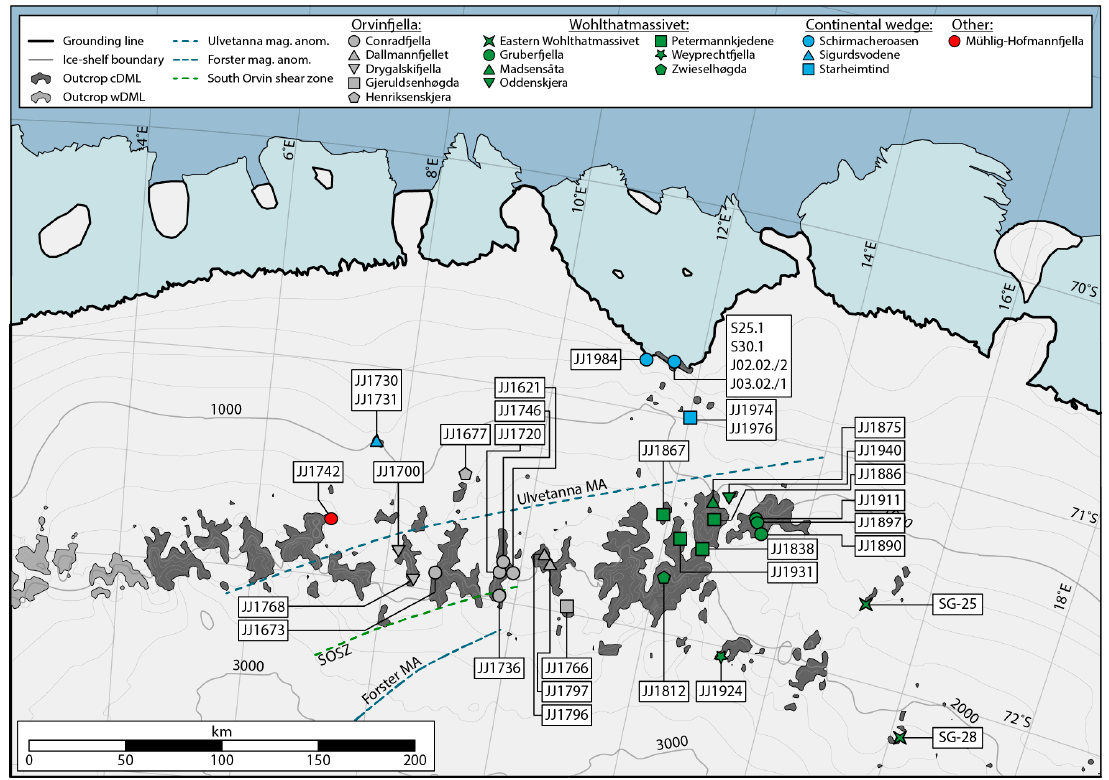
Figure 3. Overview map of sample localities and major lineaments. Lineaments after Jacobs et al. [36].